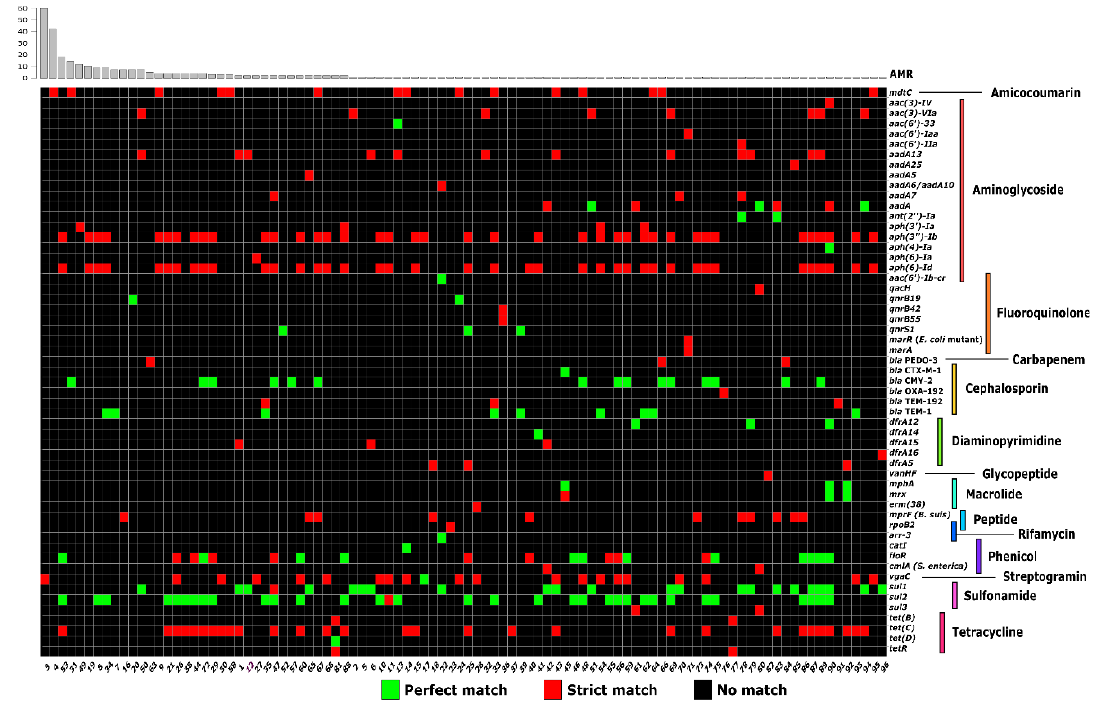
Figure 2. Antimicrobial resistance (AMR) genes of the S. enterica plasmidome predicted using the Resistance Gene Identifier (RGI) (v. 4.2.2), based on the Comprehensive Antibiotic Resistance Database (CARD) [23]. The bar plot above shows the frequency of unique resistomes. Numbers below the heatmap indicate the antimicrobial resistance profile (AMRp) (Supplementary Table S5). The AMRps were assigned to the resistome of each isolate plasmidome. The antibiotic family or function are shown on the right.